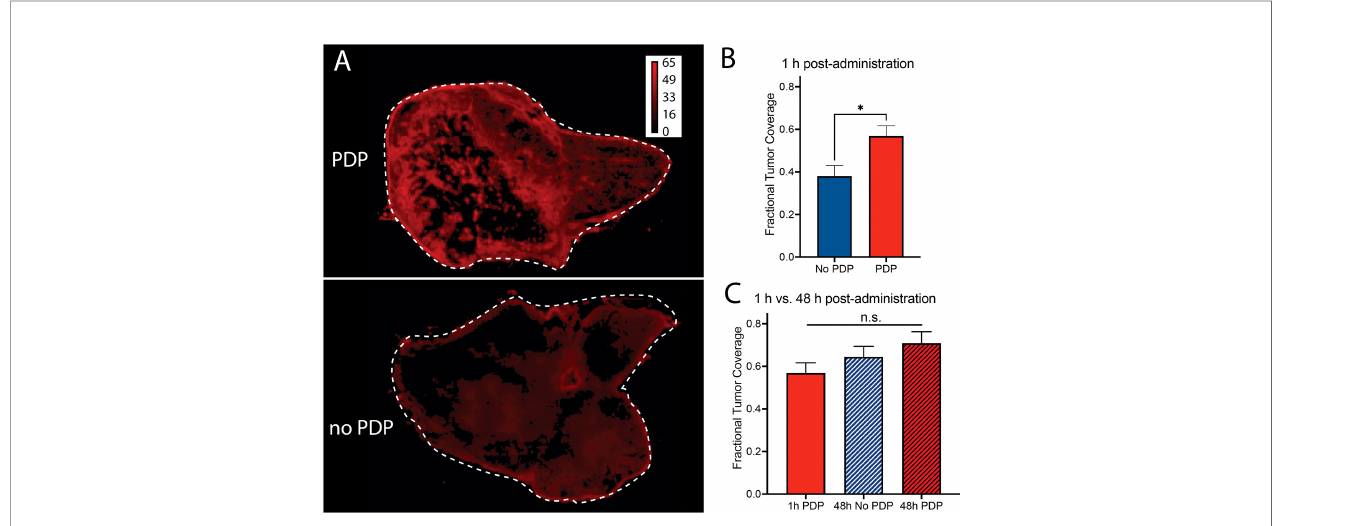
FIGURE 6 | (A, B) Fractional tumor coverage of Cet-IRDye800 in bisected tumor cross-sections is signi fi cantly increased with PDP at 1 h following intravenous administration. At 48 h, (C) no signi fi cant improvements in Cet-IRDye800 fractional tumor coverage are observed with respect to 1 h PDP. (Values are mean ± S.E.M.; statistical analysis was performed using a two-tailed t test (B) and One-Way ANOVA with a Tukey Post-Test (C) ; * P ≤ 0.05).